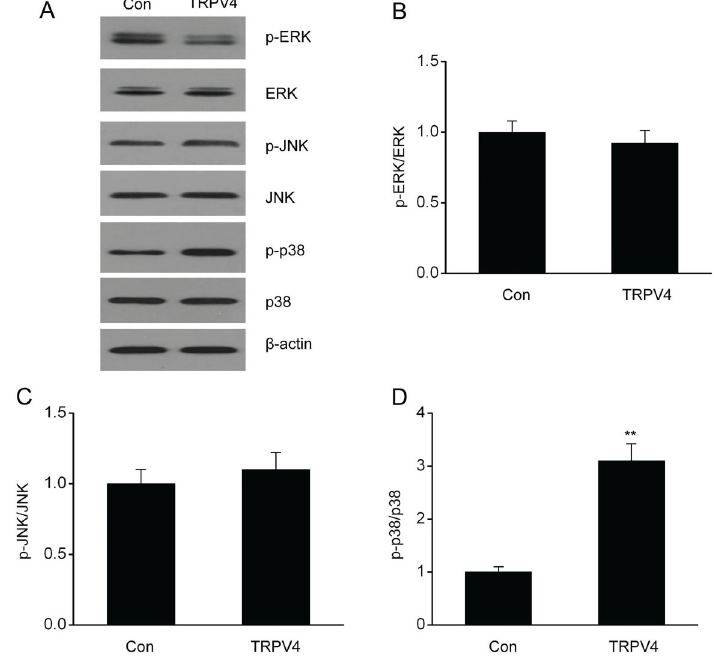
Figure 6. Overexpression of TRPV4 induced p38 MAPK pathway stimulation in a lung cancer cell line. Representative immunoblots ( A ) as well as quantitative assessment of p-ERK ( B ), p-JNK ( C ), and p-p38 ( D ) in A549 cells transfected with control plasmid pcDNA3.1( + ) (Con) and pcDNA3( + )/TRPV4 plasmid. Data are reported as means ± SE. **P o 0.01 ( t